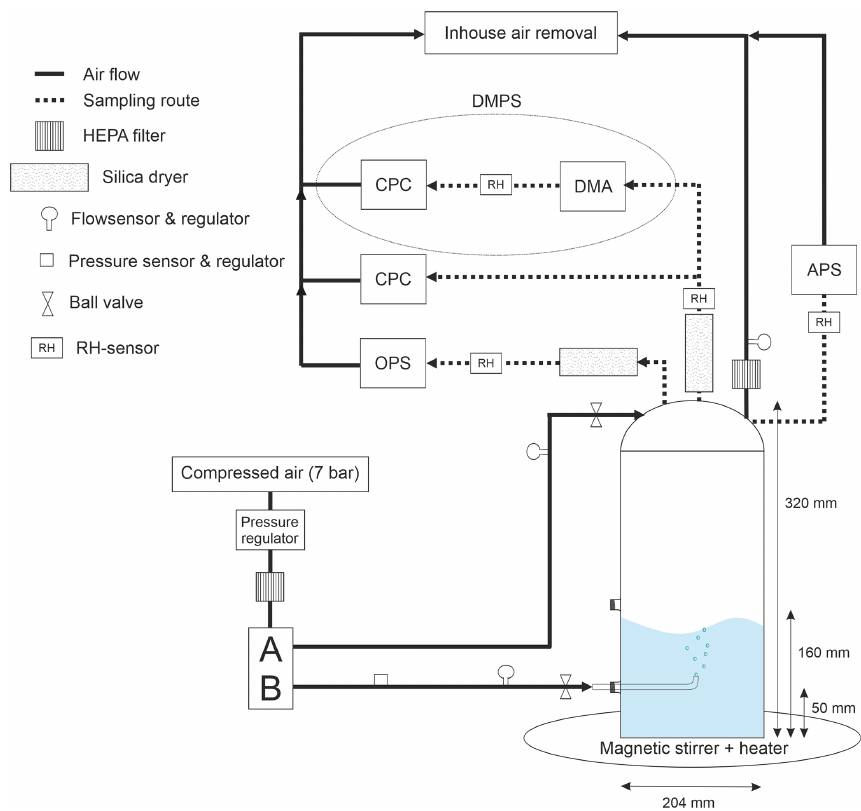
Figure B1. Schematic representation of the bubble chamber.